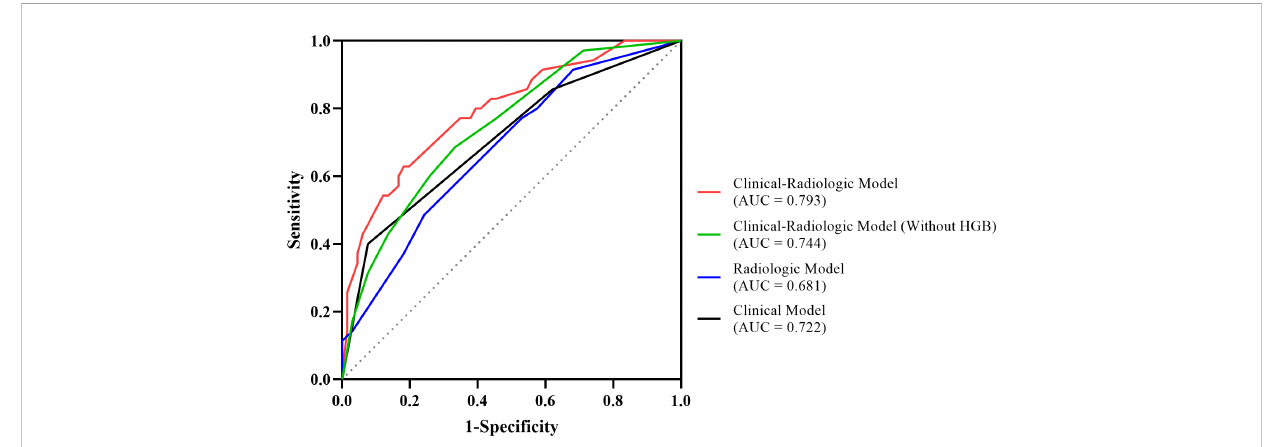
FIGURE 4 The ROC curves of the MTM-HCC prediction models. According to DeLong ’ s test, the clinical-radiologic model displayed better prediction performance than the radiologic model ( p = .03) and the clinical model ( p = .03).